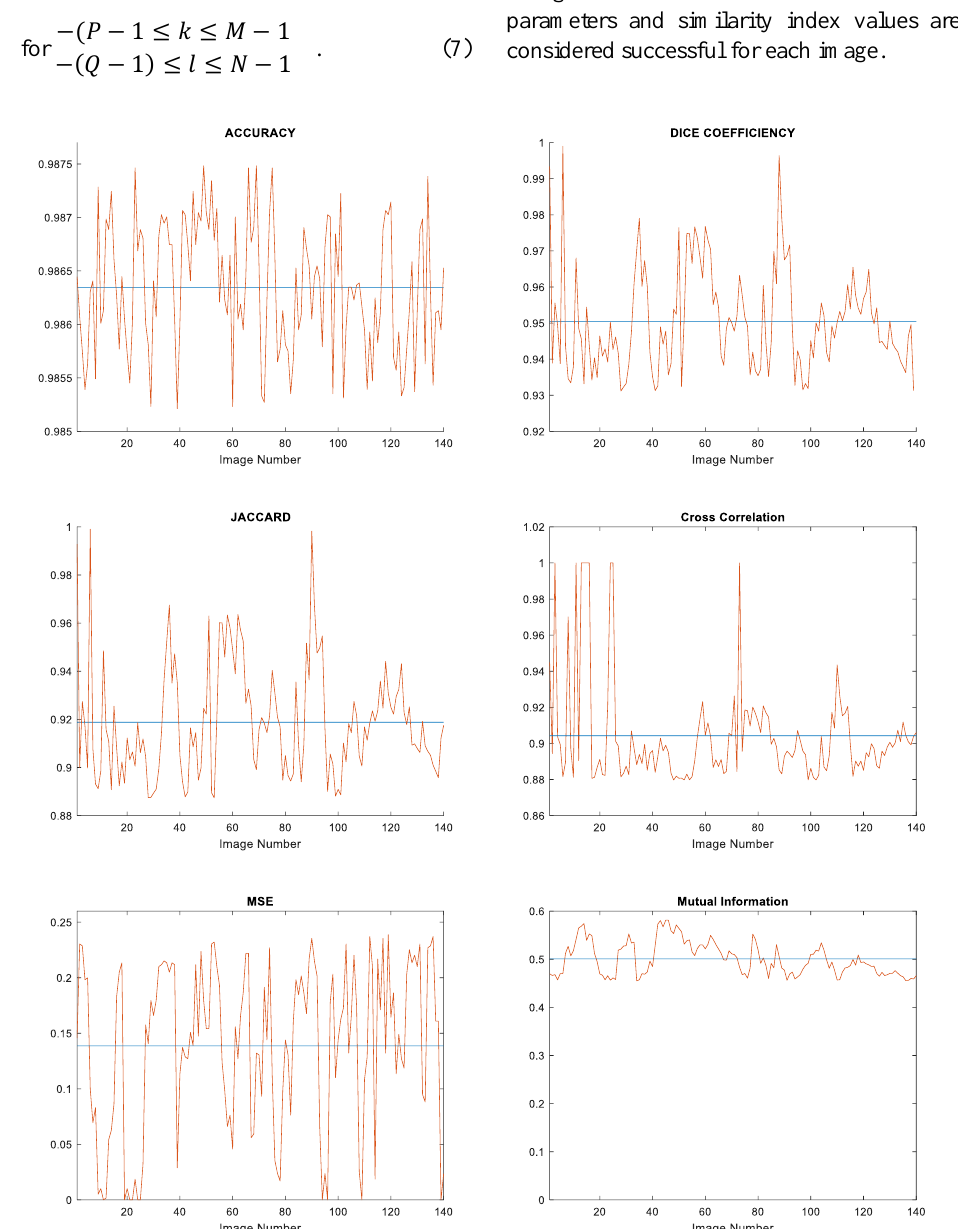
Fig. 9. Performance parameter and similarity index for data